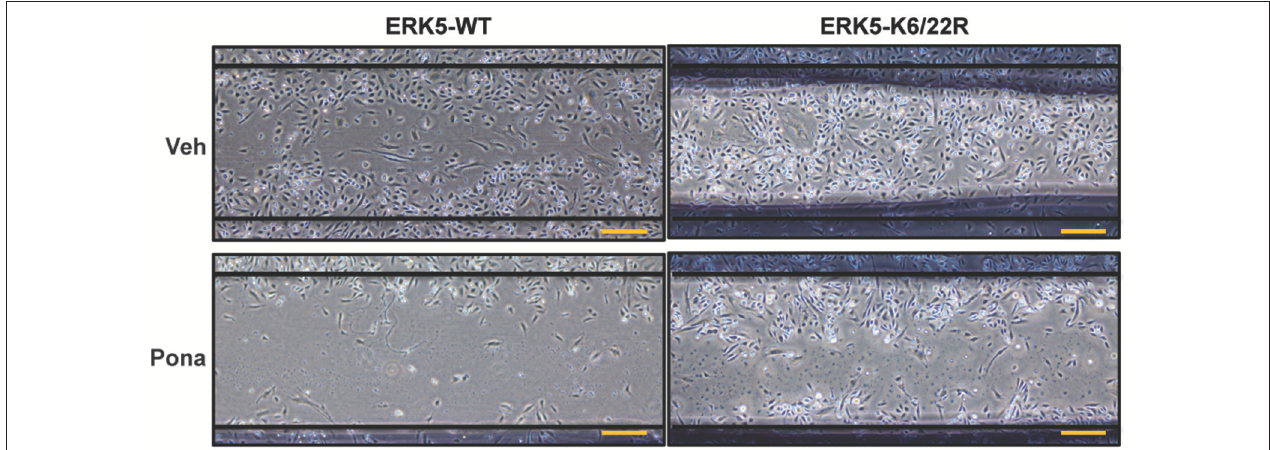
FIGURE 5 | Delayed migration of cells toward the wounded region seen in ECs expressing ERK5-WT was rescued in ECs expressing the ERK5 K6/22R mutant: Confluent monolayers of HAECs expressing Ad-ERK5-WT or Ad-ERK5-K6/22R mutant were serum starved for 1h, and then wounded with a 1000 µ L pipette tip followed by ponatinib treatment (150nM, 48h). Cells were photographed and assessed for wound closure. Scale bar represent 100 µ M. A representative data set of two independent experiments is